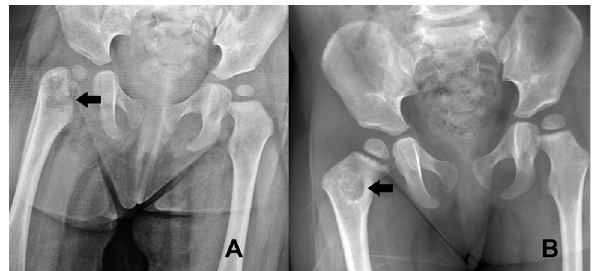
Figure 2. Radiographs of the hips of patient 2 are shown before surgery (A) and at 12-month follow-up visit (B). The arrows represent an osteolytic lesion at the right proximal